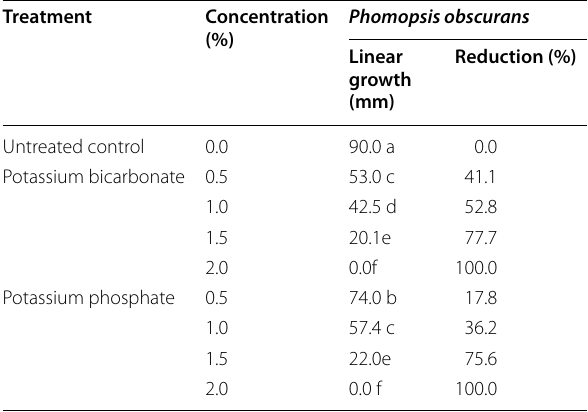
Values with the same letter are not significantly different ( P